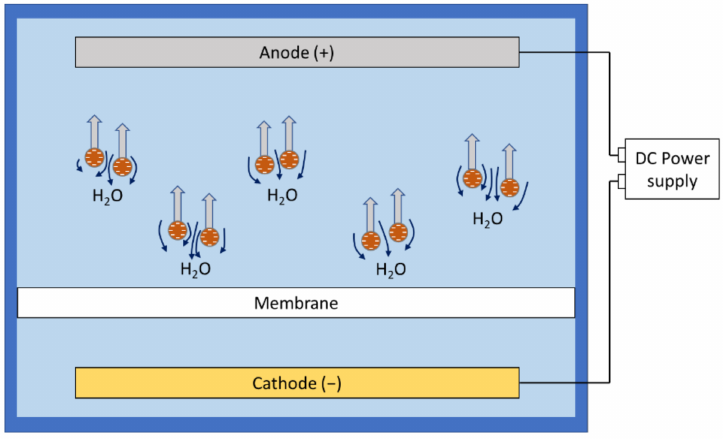
Figure 3. Electroosmosis under a direct current